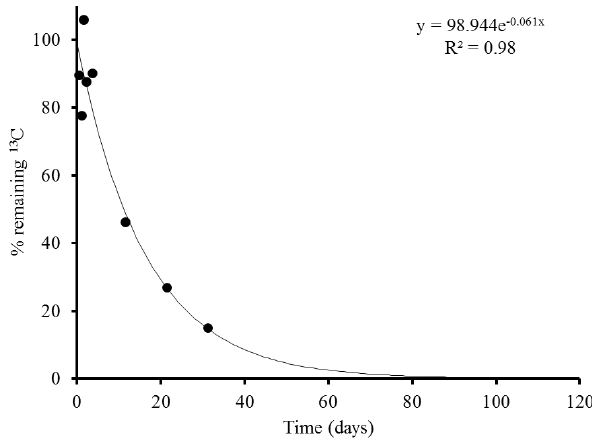
Fig. 4. Exponential curve predicting percentage of 13 C remaining in sediment organic carbon that is expected to be within MPB over time. Data points show values measured over the 31 day